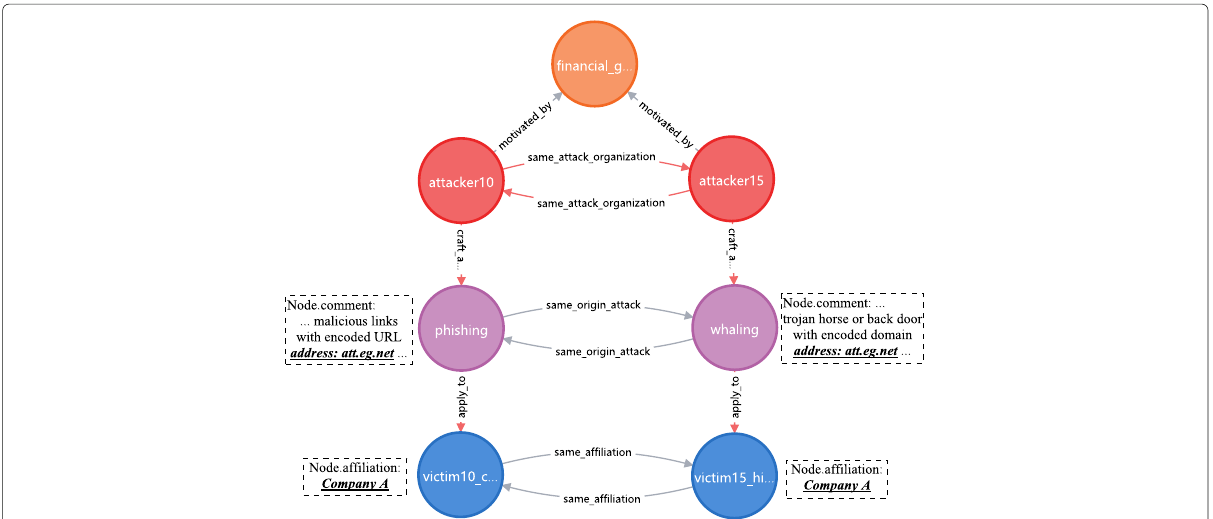
Fig. 27 Analyze the same origin attack by knowledge